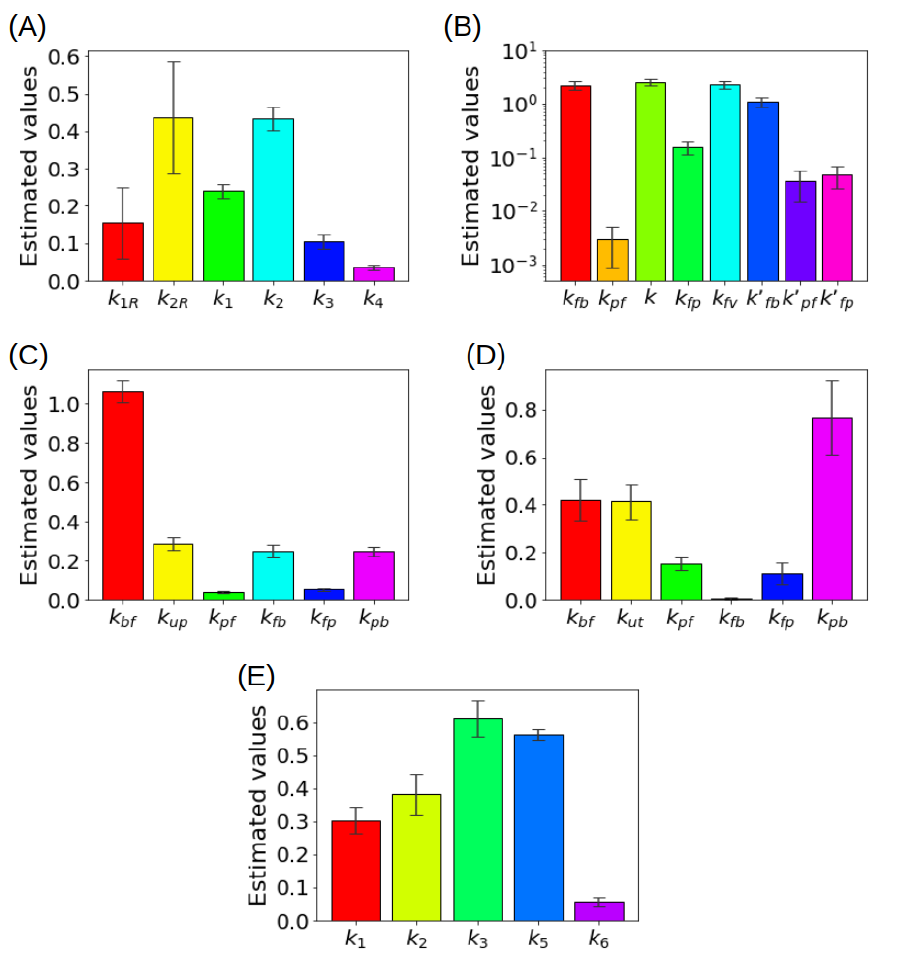
Figure 8. ( A ) Kinetic parameters estimated for the reference tissue CM with a deterministic ap- proach ( B ) Kinetic parameters estimated for the liver CM with a deterministic approach ( C ) Kinetic parameters for a simplified CM for the renal system estimated with ant colony optimization, ( D ) Kinetic parameters for the CM of the renal system estimated with a statistical approach ( E ) Ki- netic parameters of the CM including the endoplasmic reticulum estimated with a regularized Gauss-Newton